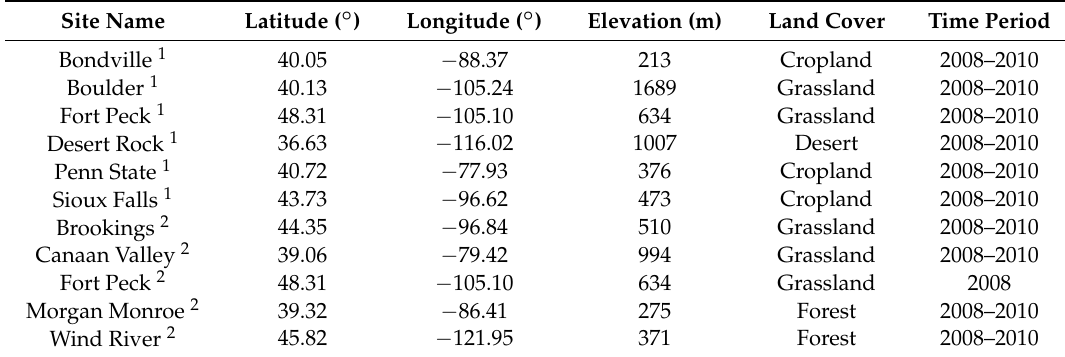
Table 1. Description of site